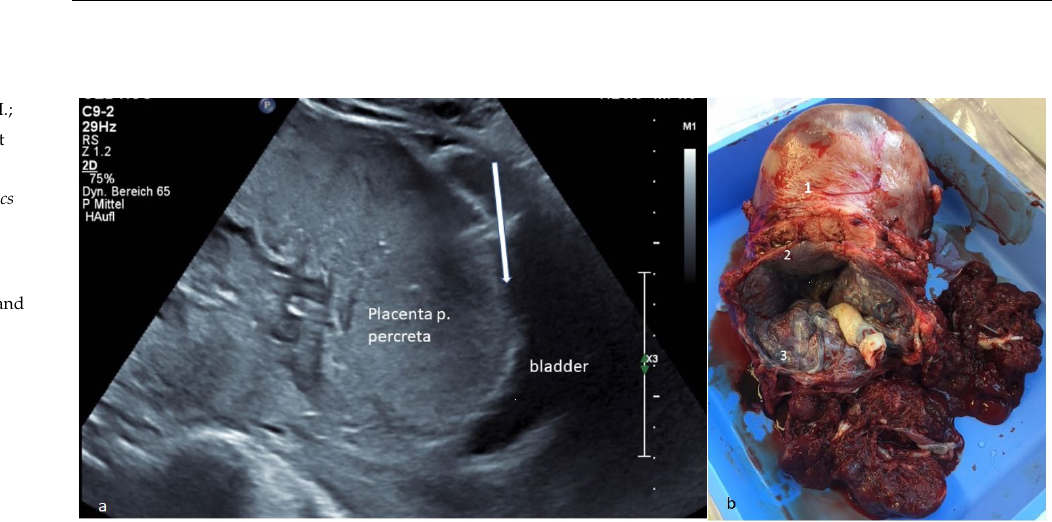
Figure 1. ( a ) Transvaginal ultrasound: presentation of a placenta previa totalis et percreta at 34 weeks gestation with a small tissue layer (arrow) towards the urinary bladder. Placenta percreta occurs in about 5% of placenta accreta spectrum (PAS) [1,2] and causes high maternal and fetal peripartum morbidity/mortality. Ultrasound was crucial for further planning. A eutrophic fetus with regular Doppler is present. ( b ) Specimen: The specimen of the subtotal resected uterus is demonstrated. The uterus (1) is marked, and the placenta previa totalis et percreta (3) detected pre- operatively on ultrasound in the lower uterine segment (CS scar (2)) is clearly seen. Intraoperatively, the suspicion was confirmed with a placenta previa et percreta with CS scar infiltration. Due to the life-threatening bleeding risk, simultaneous subtotal hysterectomy was needed. Placenta percreta is the most severe form, characterized by placental invasion through the entirety of the myometrium and possibly into extrauterine tissues [2]. The diagnosis was confirmed histologically. Maternal blood loss was 1.7l (2 red-blood-cell concentrates were administered). There was a good maternal and fetal outcome (fet 2490 g, inconspicuous APGAR/pH). The most common predisposing risk factor is a previous CS [3,4], as in the case presented. The higher the number of previous CS, the higher the PASrate [2]. Typically, PAS is associated with placenta previa [3] as well. Sometimes, life- threatening hemorrhage can occur, which often requires a blood transfusion [2,5]. The gold standard treatment is cesarean hysterectomy 2 . This case demonstrates the great importance of prenatal diag- nosis with immediate realization of the dimensions of this very rare finding, especially with the increasing CS rate and other associated complications [4,6,7] . Author Contributions: Conceptualization, C.B. and M.H.; methodology, C.B.; validation, C.B.; for- mal analysis, C.B.; investigation, C.B.; resources, C.B., M.H. and H.A.; data curation, C.B.; writing— original draft preparation, C.B.; writing—review and editing, C.B., M.H. and H.A.; visualization, C.B. and M.H.; supervision, C.B.; project administration, C.B.; funding acquisition, C.B. All authors have read and agreed to the published version of the manuscript. Funding: We acknowledge support by Open Access Publishing Fund of University of Tübingen. The funding body played no role in the design of the study and collection, analysis, and interpreta- tion of data and in writing the manuscript. Institutional Review Board Statement: The study was conducted in accordance with the Declara- tion of Helsinki. The study did not require ethical approval. Informed Consent Statement: Informed consent was obtained from all subjects involved in the study; Written informed consent has been obtained from the patient to publish this paper. Data Availability Statement: All data regarding this case are published within it, for further ques- tions please aks the authors. Conflicts of Interest: The authors declare no conflict of interest.